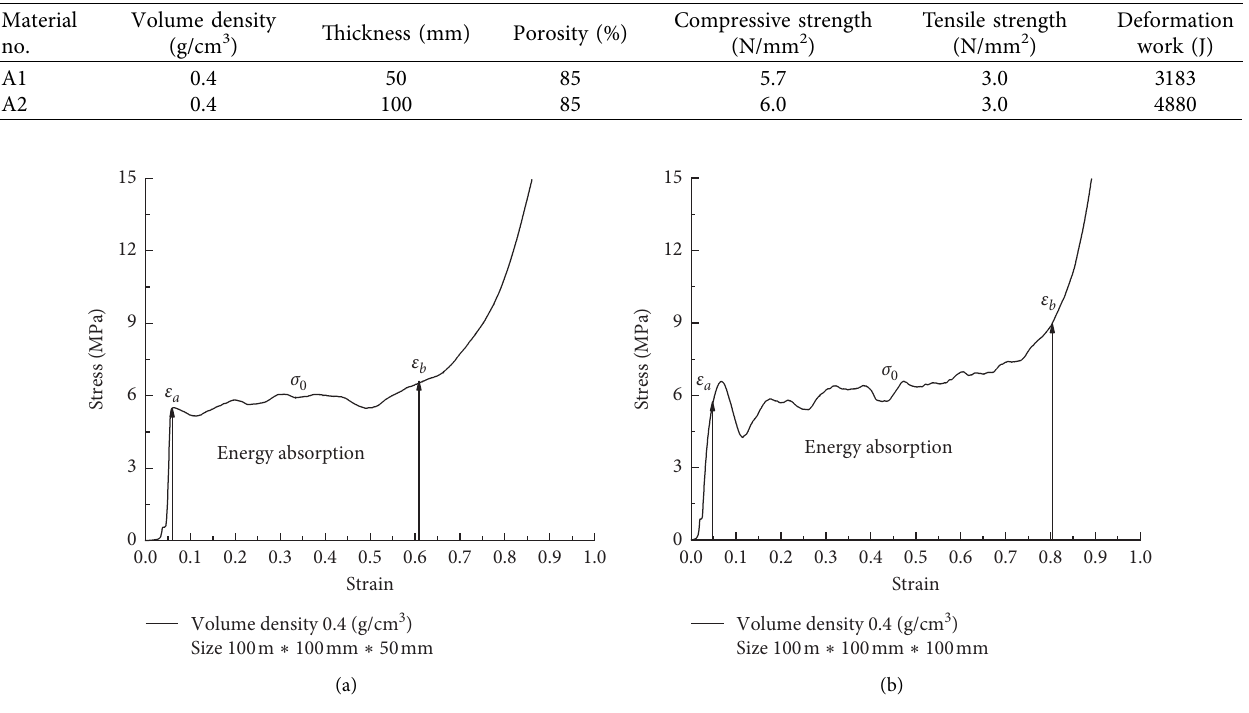
Figure 3: Stress-strain curves of the uniaxial compression tests of the closed-cell aluminum Table 2: Design of the test specimen.